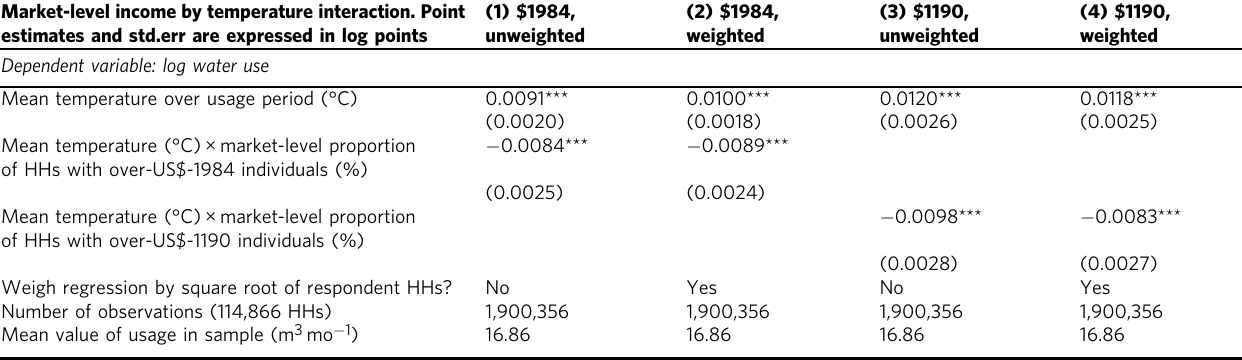
Table 2 Heat-water response is lower in markets with higher average income Market-level income by temperature interaction. Point estimates and std.err are expressed in log